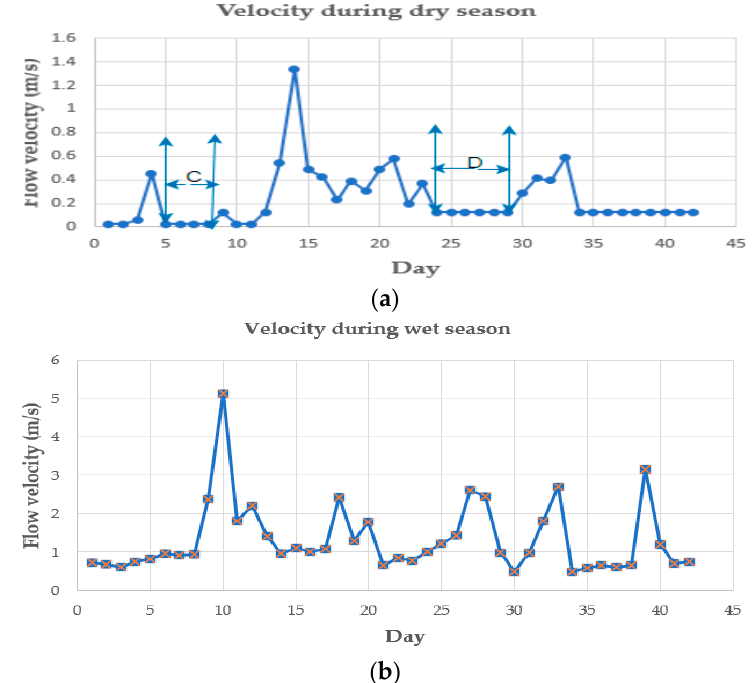
Figure 8. Flow velocity ( a ) in dry season months and ( b ) in wet season months.